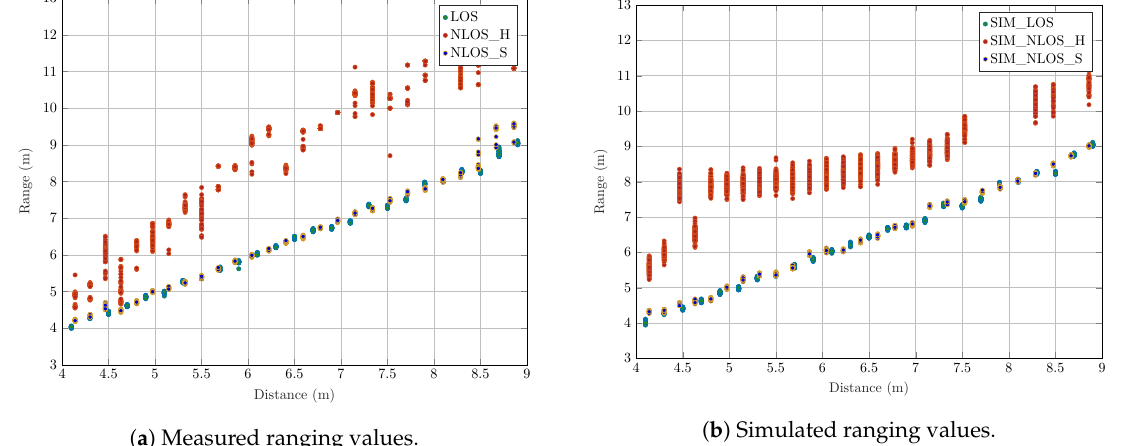
Figure 3. Simulated ranging values corresponding to the measurement scenario and comparison with the measured ranging values.